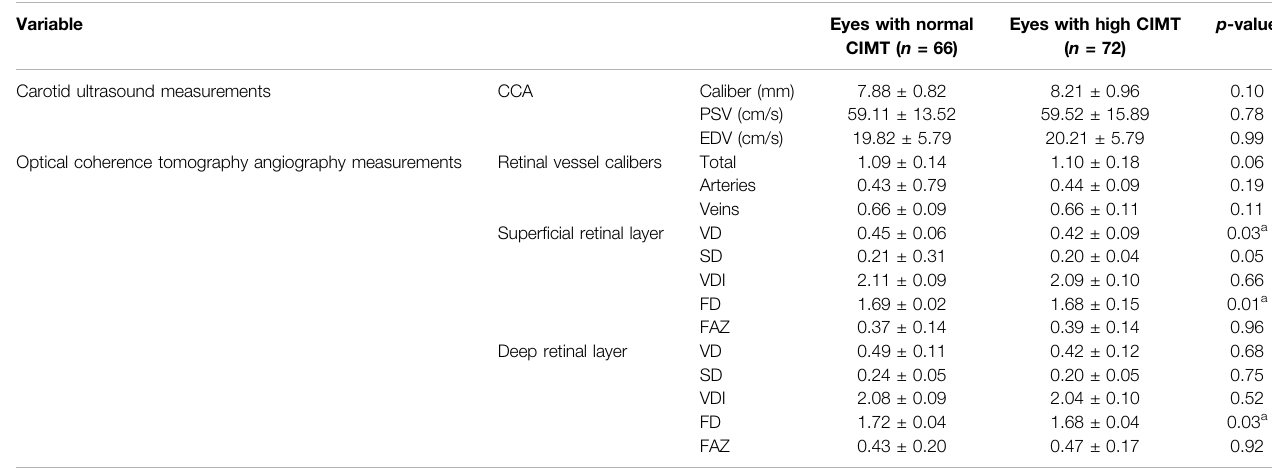
TABLE 2 | Independent t -test ofcarotidultrasonographical variables and optical coherence tomography angiography databetweeneyes withnormal and thickened carotid intima media thickness.